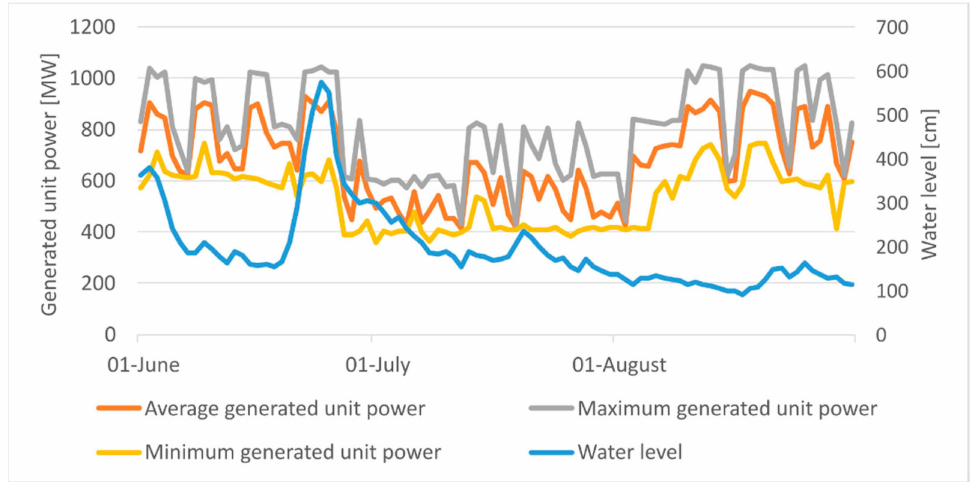
Figure 18. Diagram of the average daily water level in the Wisła River (Szczucin) with the minimum, average, and maximum daily power generated in the Połaniec power